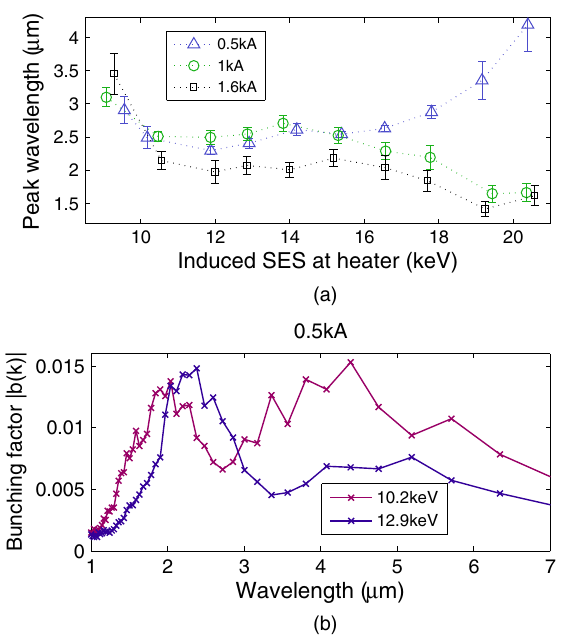
FIG. 5. (a) The peak bunching factor shifts to shorter wave- lengths as the heater amplitude increases, but the behavior is more complicated at large amplitude. (b) A zoom of two curves from Fig. 4(a) highlights the complex behavior of the multi-stage MBI, such as a double peak in the bunching